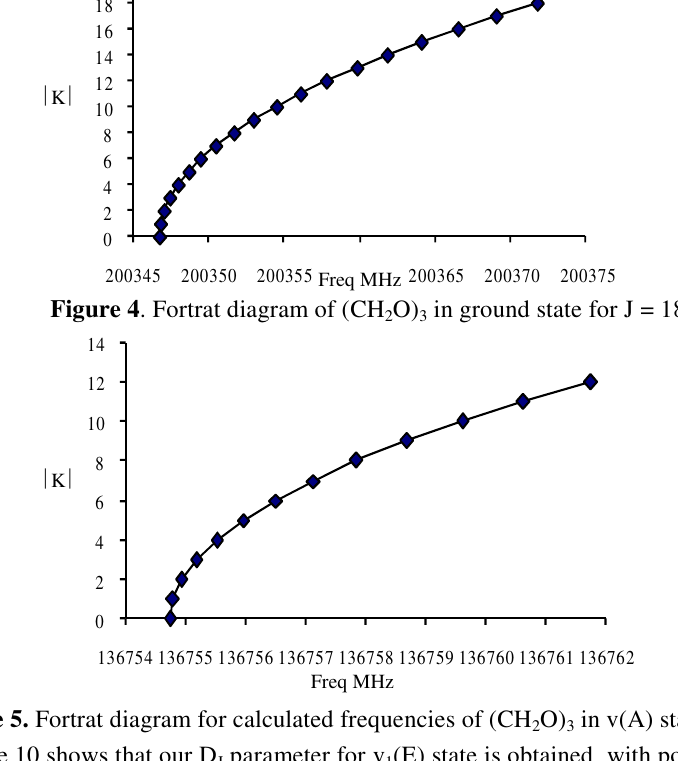
O) in v(A) state for J = 12 2 3 MHz (11) 1940.54- C ζ = and q J = 0.0753 (97)